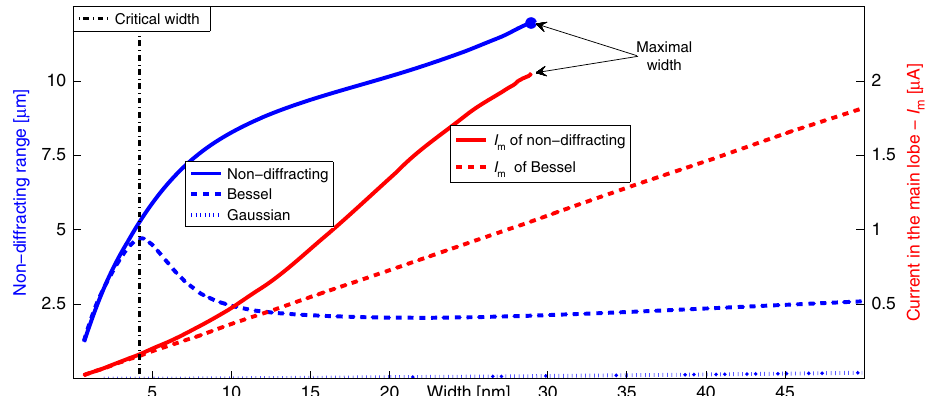
Fig. 4 Non-diffraction range and effective current vs. beam width. The plot shows the non-diffraction range ( blue curves ) and effective current ( red curves ) vs. beam width, for our non-diffracting wavefunctions ( solid curves ), for multi-electron Bessel ( dashed curves ) and Gaussian (dotted curve) EBeams with zero OAM. The effective width of our non-diffracting multi-electron beam is bounded from above at the blue dot , where the main lobe is over-wide, carrying the upper limit on the current. This upper limit occurs because the interference of our shaped wavepacket can balance the beam self-repulsion and diffraction only up to a certain value, above which the beam spread is too strong for the predesigned interference effects (arising from the structure of the beam) to compensate for it. For beams of effective width much narrower than the critical width (marked by the dashed vertical line at 4.2 nm) our non- diffracting multi-electron wavefunction coincides with the Bessel function. This critical width decreases as the current is increased and can go below 1 nm. Here, the EBeams are accelerated by voltage of 200 V, having beam current of I = 5 μ